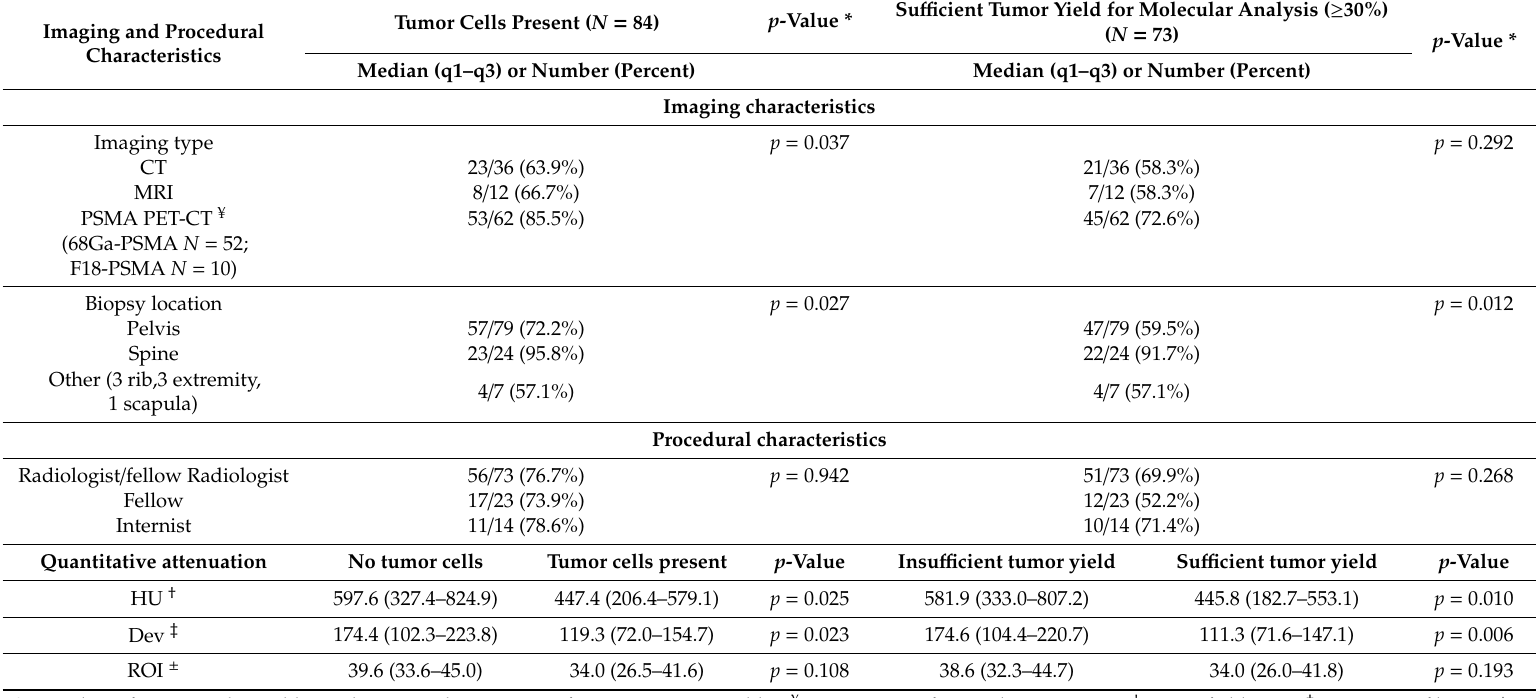
Table 2. Imaging and procedural